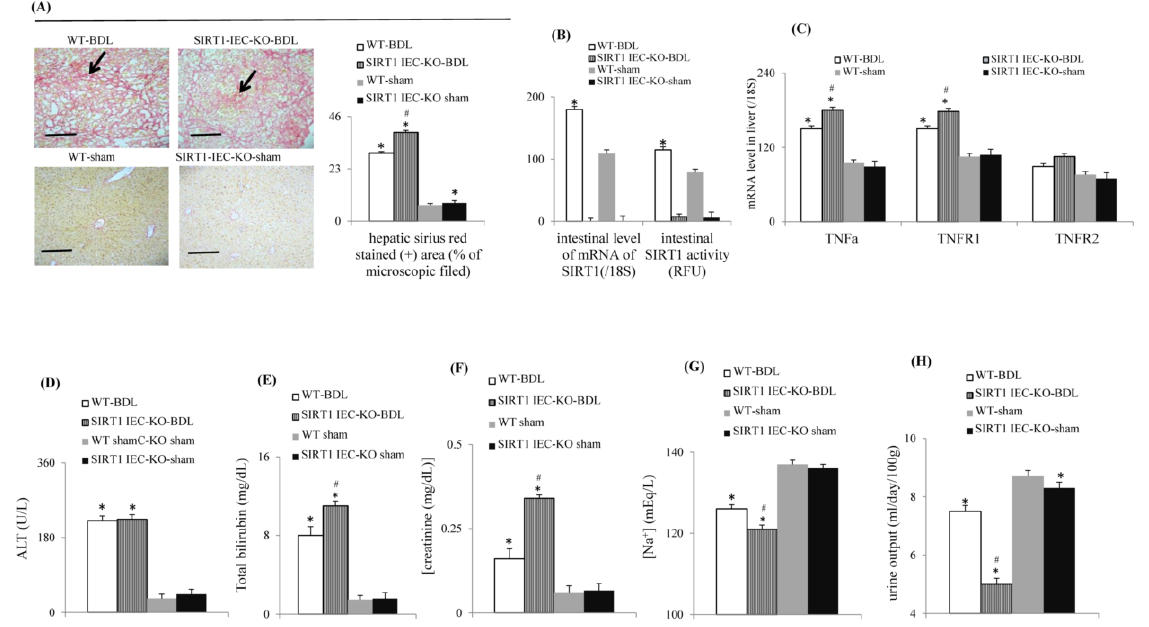
Figure 1. Intestinal SIRT1 deficiency aggravates hepatic fibrosis and renal dysfunction in bile duct ligated (BDL) cirrhotic mice with ascites. ( A ) Sirius red staining (+) (arrowhead) of mice liver section (20 × , the scale bar is 100 μ m); ( B ) intestinal SIRT1 levels; ( C ) hepatic levels of TNF α , TNFR1 and TNFR2 genes; ( D ) serum levels of ALT, ( E ) total bilirubin, ( F ) creatinine and ( G ) sodium; ( H ) urine output among groups. * vs. WT-sham mice; # vs. WT-BDL mice.